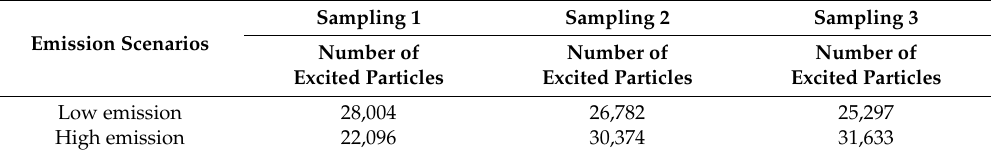
Table 3. Sample size of different samples for fluorescence intensity data from the aerosolisation